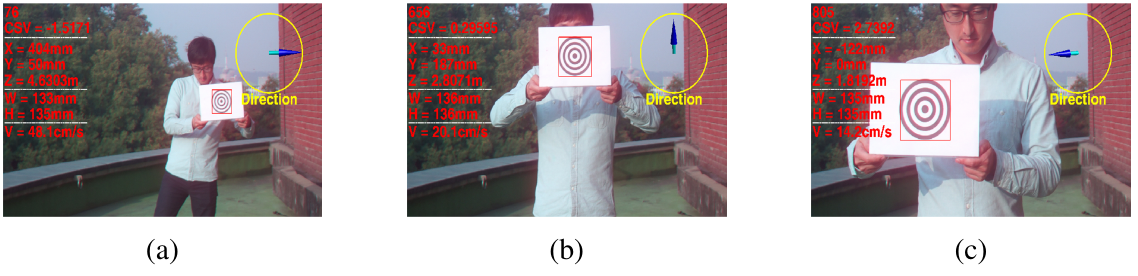
Figure 8. Estimation results of the 3D states of the object ˙x 76th frame; ( b ) 656th frame; ( c ) 805th frame.